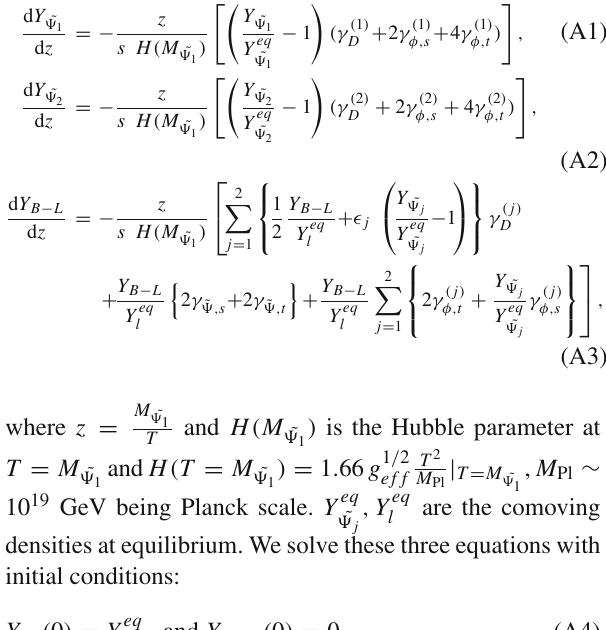
Fig. 9. The lepton asymmetry is further can be translated